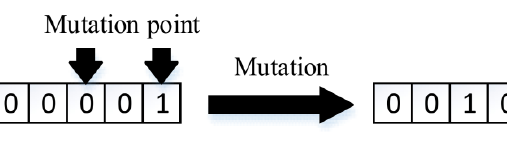
Figure 7. Mutation.